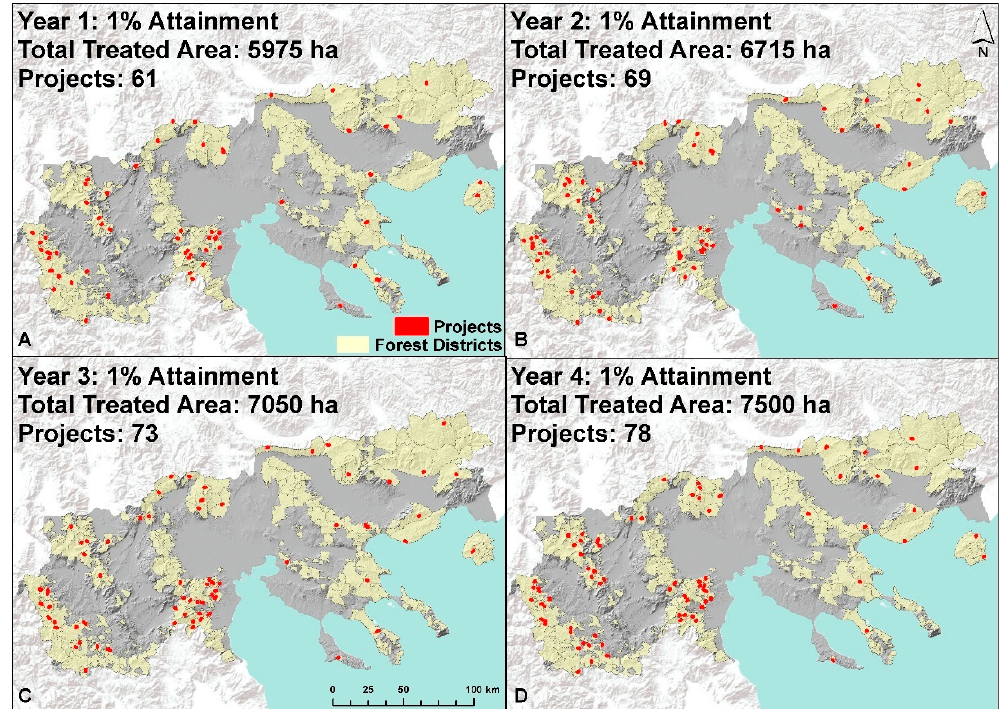
Figure A3. Annual fuel treatment locations of the best 100-hectare projects for a four-year period, as estimated from the prioritization of ecosystem services.